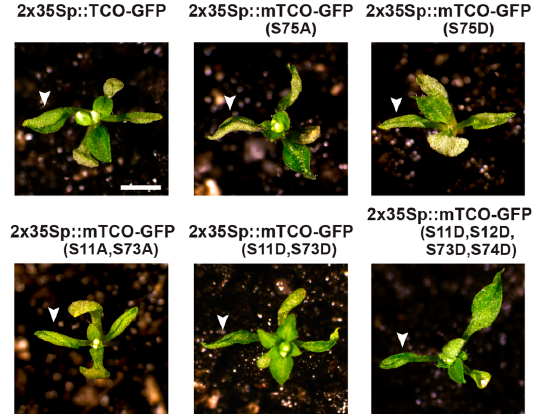
Figure 8. Phenotypic effects of overexpressing TCO-GFP transgenes in Arabidopsis . At 23 days after germination, primary transformants of phospho-deficient and phospho-mimic 2x35Sp::mTCO-GFP transgenes resembled those of 2x35Sp::TCO-GFP, all of which displayed short, curled leaves (arrowheads) and flowered early. The lone exception was 2x35Sp::mTCO(S11A,S12A,S73A,S74A)-GFP for which primary transformants could not be isolated.